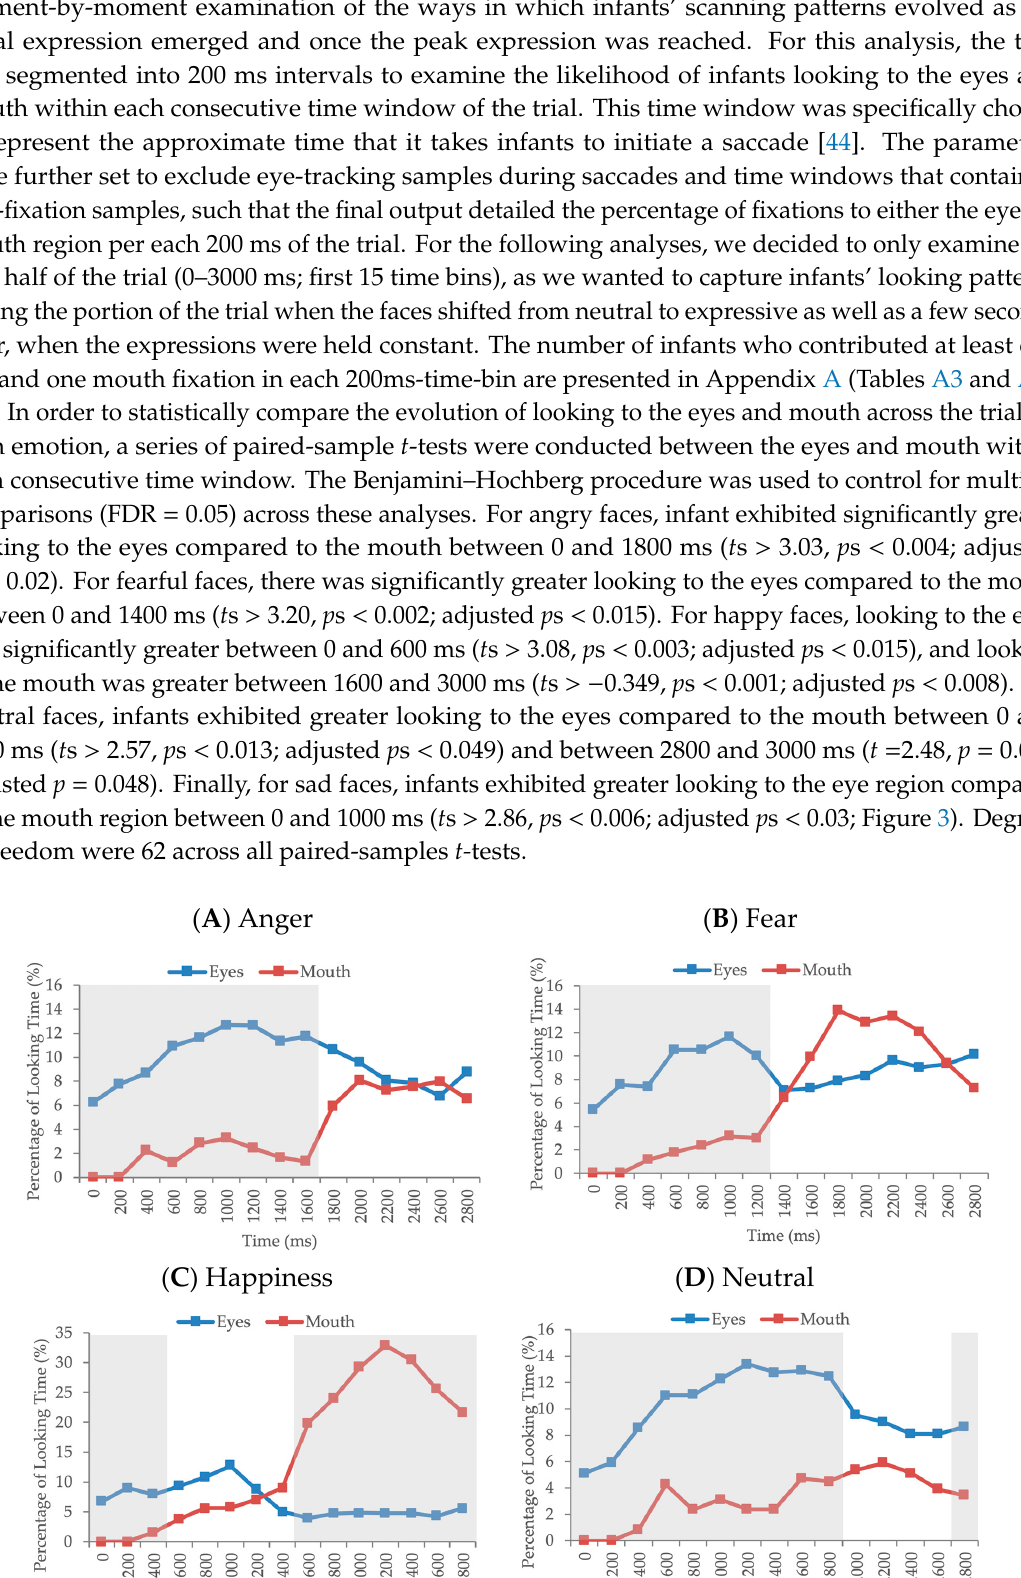
Figure 3. Time-course analysis: percentage of looking time to the eyes and the mouth over the first 3000 ms of the trial presented for ( A ) Angry; ( B ) Fearful; ( C ) Happy; ( D ) Neutral; and ( E ) Sad faces ( n = 63). Time intervals with significant differences are highlighted in the grey boxes ( p s < 0.016; adjusted p s < 0.049). 3.4. Visual Salience Analysis Recognizing that a compelling interpretation of the current findings is that infants’ looking patterns may be driven by low-level visual properties of the stimuli, we conducted a visual salience analysis of each stimulus using the Matlab Saliency Toolbox [45]. By assessing the low-level visual properties of an image (e.g., color, intensity), this toolbox produces a “heat map” that highlights visually salient areas of an image. For each of the 25 dynamic stimuli used in the current study (5 identities × 5 facial expressions), we used an image of its peak expressiveness [42]. Each of these images was analyzed using the Saliency Toolbox. Saliency maps for one identity are portrayed in Figure 4 and the saliency maps for all of the identities can be found in Supplementary Figure S1. The saliency maps are relatively consistent across different facial expressions, with external features (e.g., hairline, shoulders) and the eyes (particularly the left eye from the viewer’s perspective) appearing as the most visually salient features. Notably, the mouth region of the happy facial expression was not noticeably more salient than the mouth region of the other facial expressions; in fact, the mouth region appeared more salient in the fearful, sad, and/or neutral expressions compared to the happy facial expression for several of the identities. This finding suggests that infants’ enhanced attention to the mouth of the happy facial expressions (compared to the other facial expressions) may not be explained by the low-level visual salience of the mouth region alone.